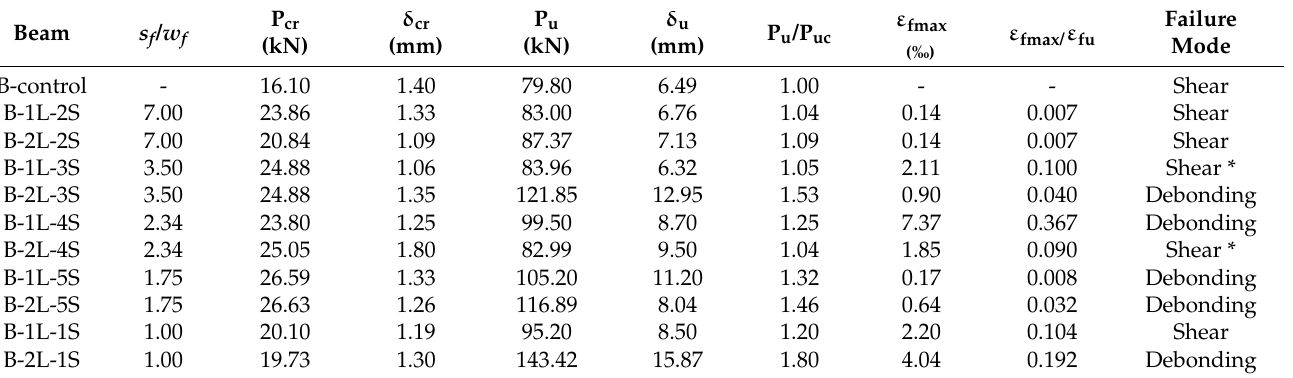
Table 3. Test results.